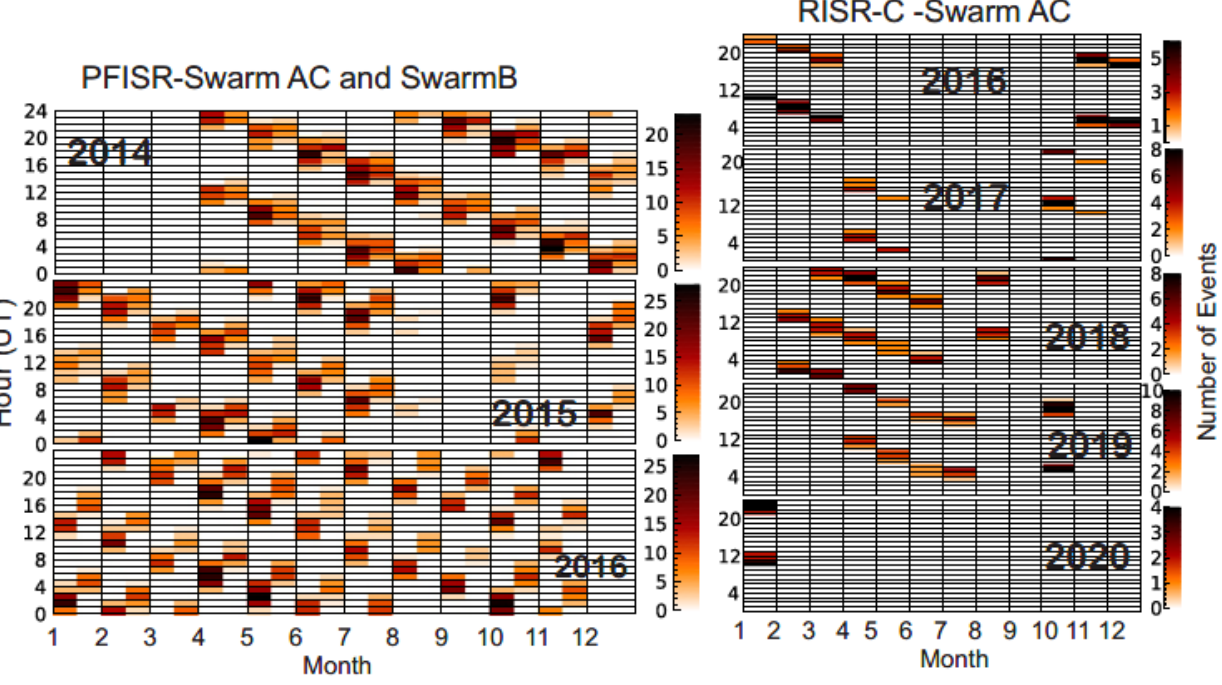
Figure 2. Number of joint ISR–Swarm measurements on the UT ‐ month plane for observations over Poker Flat (PF), left panels, and Resolute Bay (RISR ‐ C radar, Nunavut, Canada), right panels. For the Poker Flat data, each UT ‐ month cell is divided into two halves with the left half for each month corresponding to the radar ‐ Swarm AC conjunctions while the right half of each month corresponds to the radar ‐ Swarm B conjunctions.